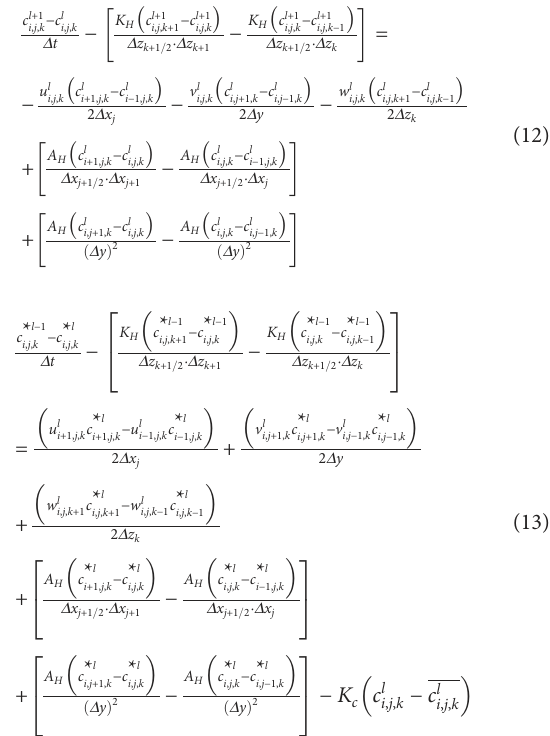
The computational domain was 38.5°N-41°N, 119.5°E- 122.5°E (the Liaodong Bay) with a 4 ′ × 4 ′ horizontal resolution. There were 6 layers in vertical pro fi les. The depth of each layer from top to bottom was 10m, 20m, 30m, 50m, 75m, and 100m, respectively. The computing time was 30 days and the time step was set to be 6 h. The hydrodynamic fi eld was provided by POM, as described above. In order to improve the simulation accuracy of the adjoint assimilation model, the independent grids were selected every 4 common grids. Only the